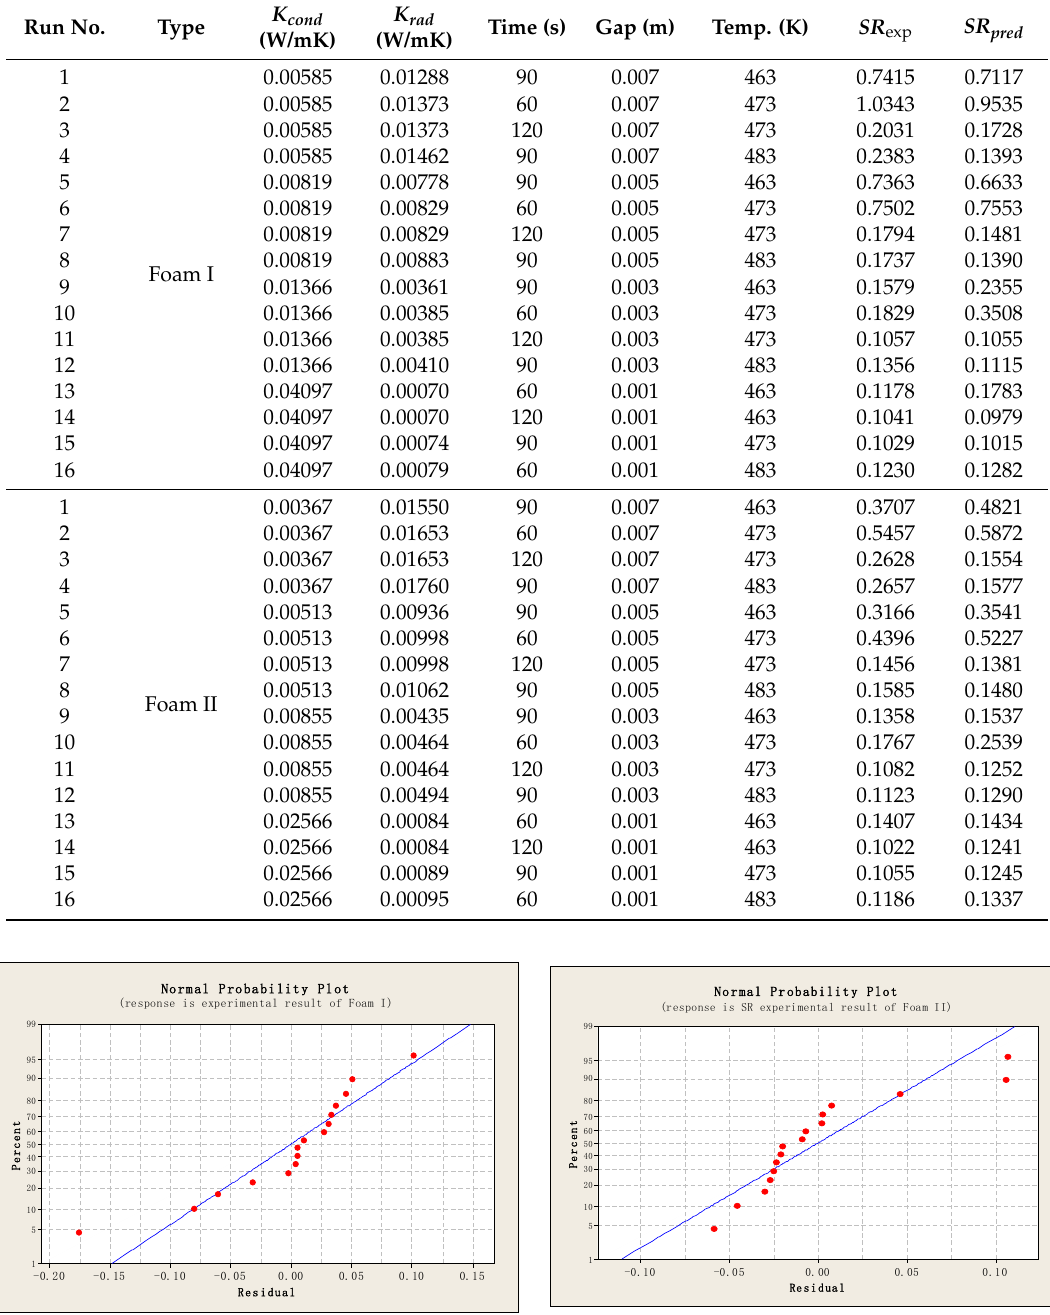
Table 3. The 16 random verification runs of each foam.